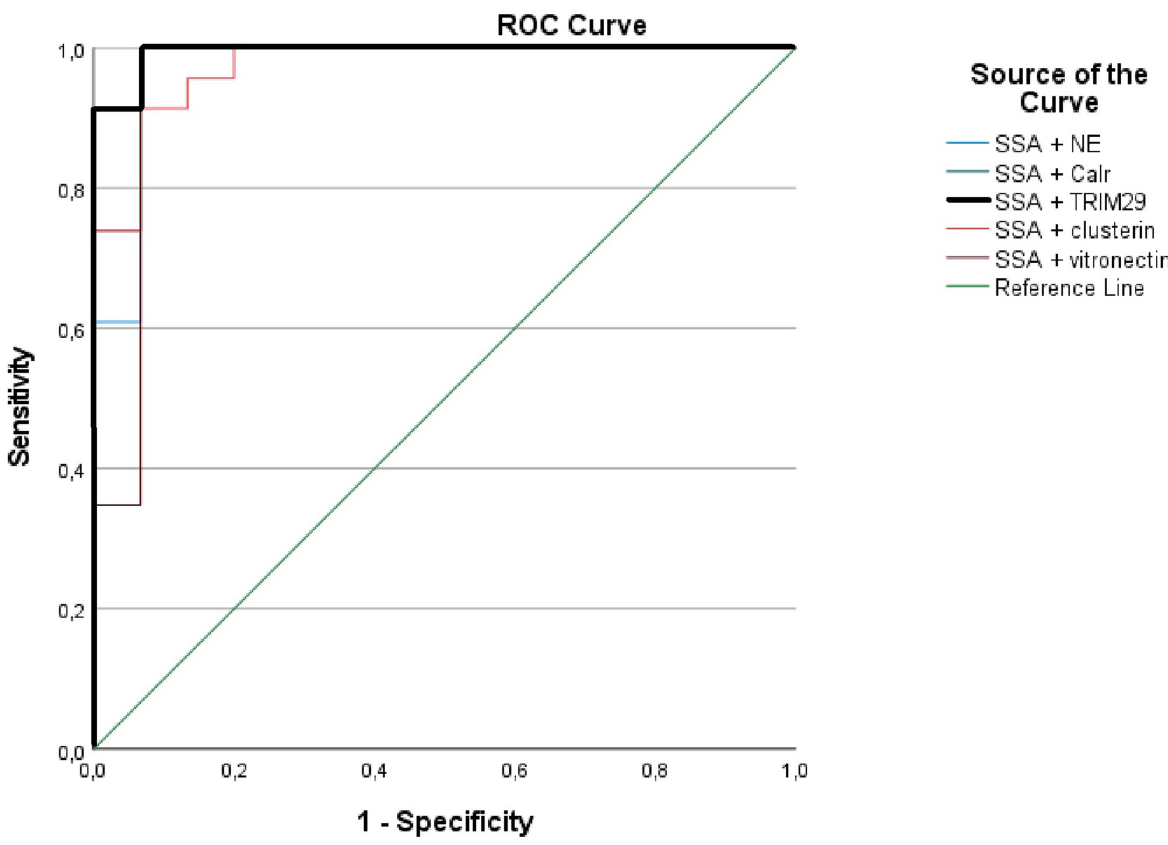
Fig 1. Receiver operating characteristic curve showing the largest area under the curve (upper left corner) of 99.5% for anti-SSA/Ro + TRIM29 combination curve (bold black line).